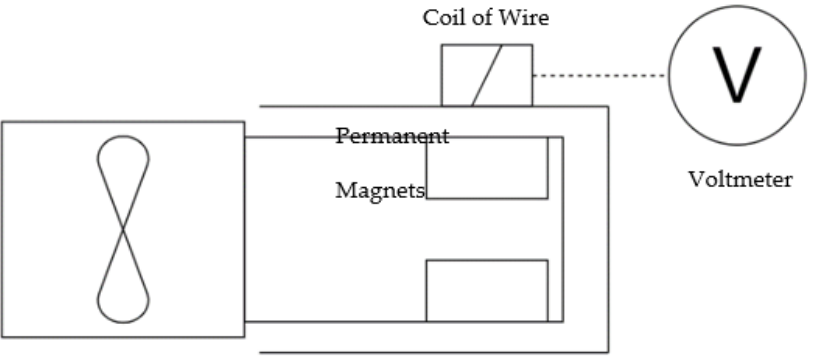
Figure 4. Schematic of the electronics setup.